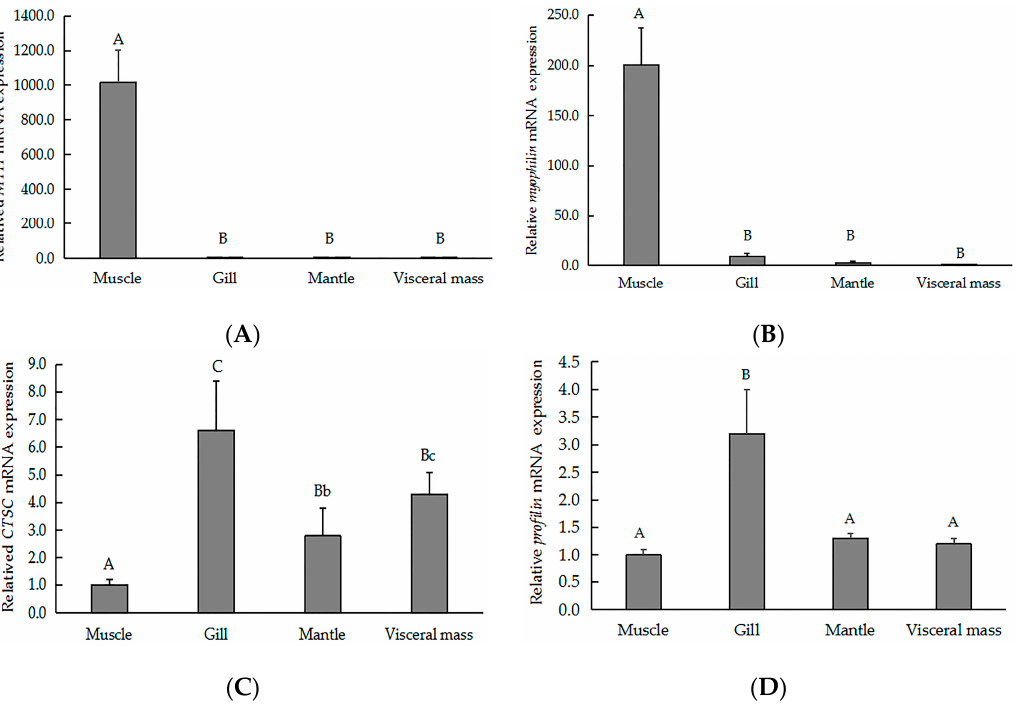
Figure 5. QRT-PCR analysis indicating the relative gene expression of ( A ) MYH , ( B ) myophilin , ( C ) CTSC , and ( D ) profilin across various tissues of the of H. discus hannai . Gene expression levels were normalized to 18S rRNA . Data are expressed as the means ± SD of at three biological replicates. Different letters represent statistically significant differences. Lowercase and capital letters indicate p < 0.05 and p < 0.01, respectively.